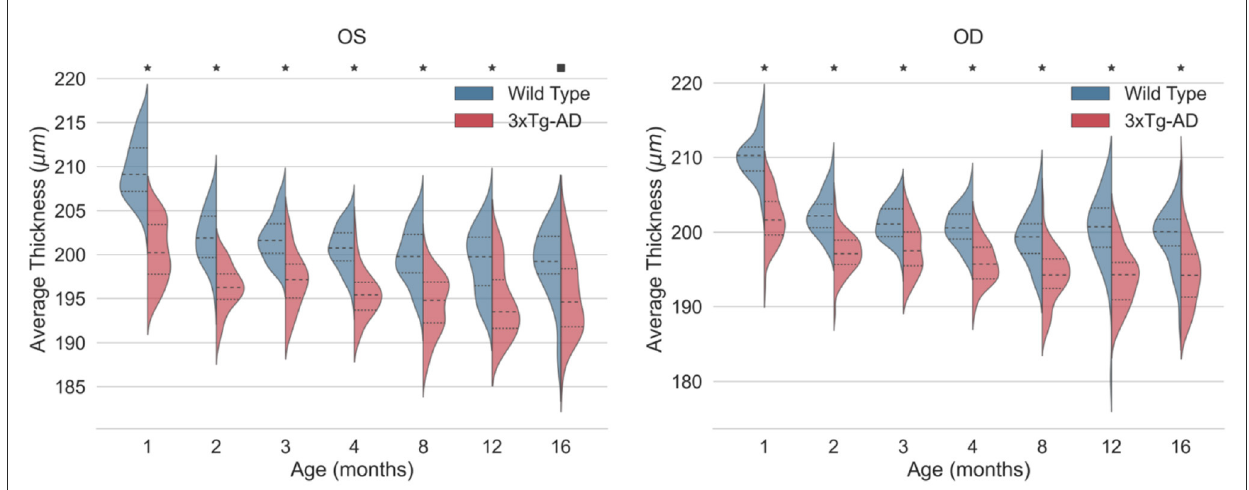
FIGURE3 Kernel density estimates of the total retinal thickness (TRT) for the left eye (OS) and right eye (OD) of wild-type (blue) and the triple transgenic Alzheimer’s disease (3xTg-AD) mice (red). Median (dashed) and first and third quartiles (dotted) are shown. p -values < 0.01 ( (cid:4) ) and < 0.001 (*).